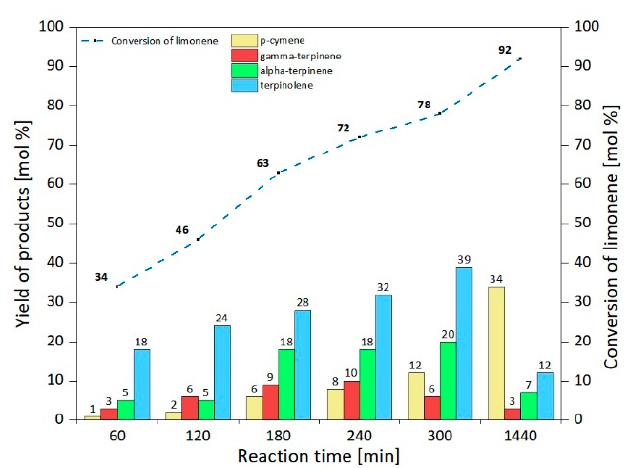
Figure 12. Influence of reaction time on the yield of products of the isomerization of limonene at 170 ◦ C.